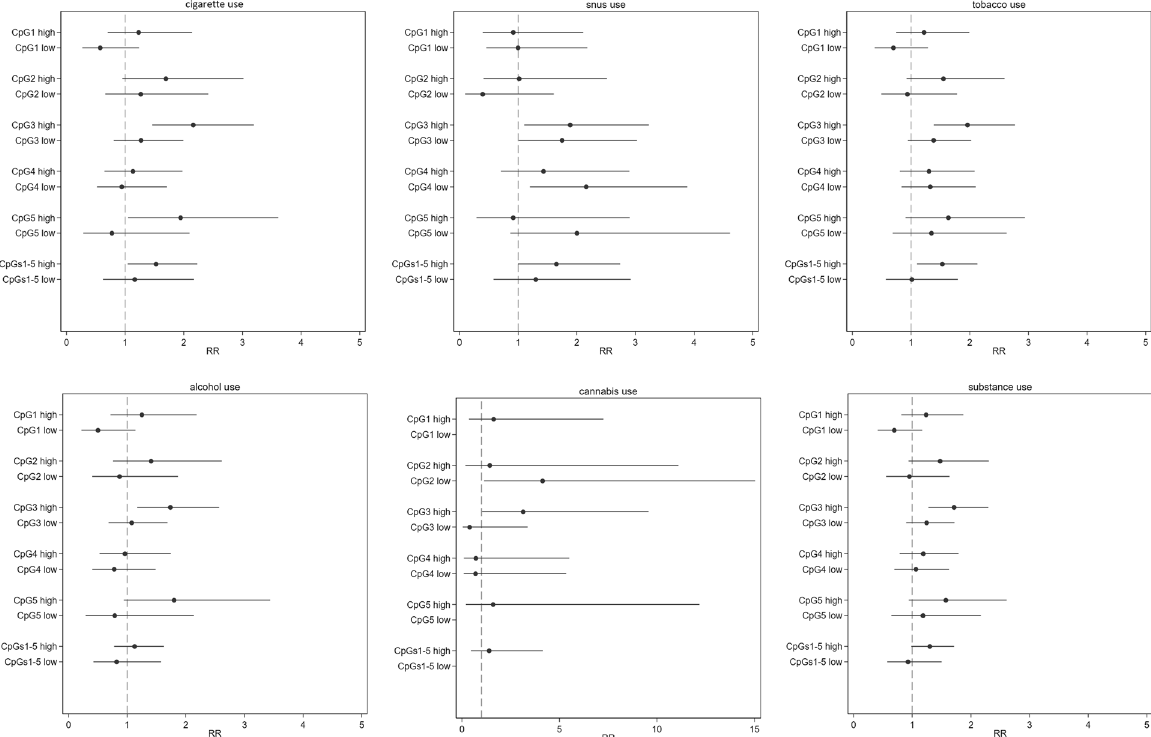
Fig. 4 Bi-variate association between NR3C1 methylation levels at baseline and duration of substance use (per year increase) assessed over three years in adolescent participants of the KUPOL study. The results should be interpreted in terms of risk ratio (RRs) with 1 as a null value. Methylation level 0% was considered as the reference category. Low methylation group: methylation levels below the median of detectable methylation and high methylation group: methylation levels above the median. RRs were not estimated for the CpG1 CpG5 and CpG1 – 5 sites with low methylation for cannabis use given no cases in these